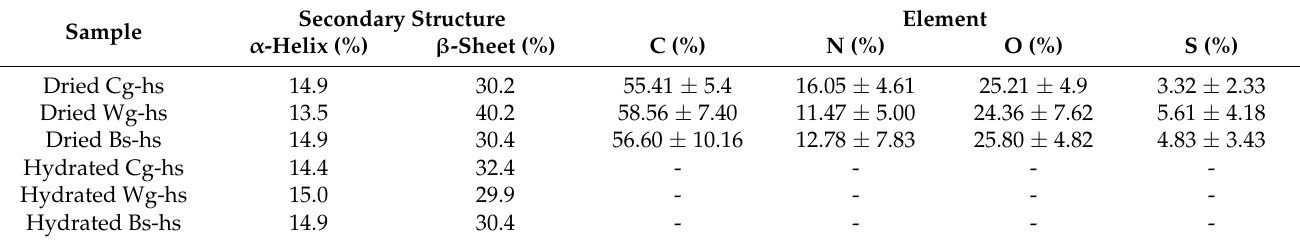
Table 2. The secondary structure and main element content in different Caprinae horn sheaths.